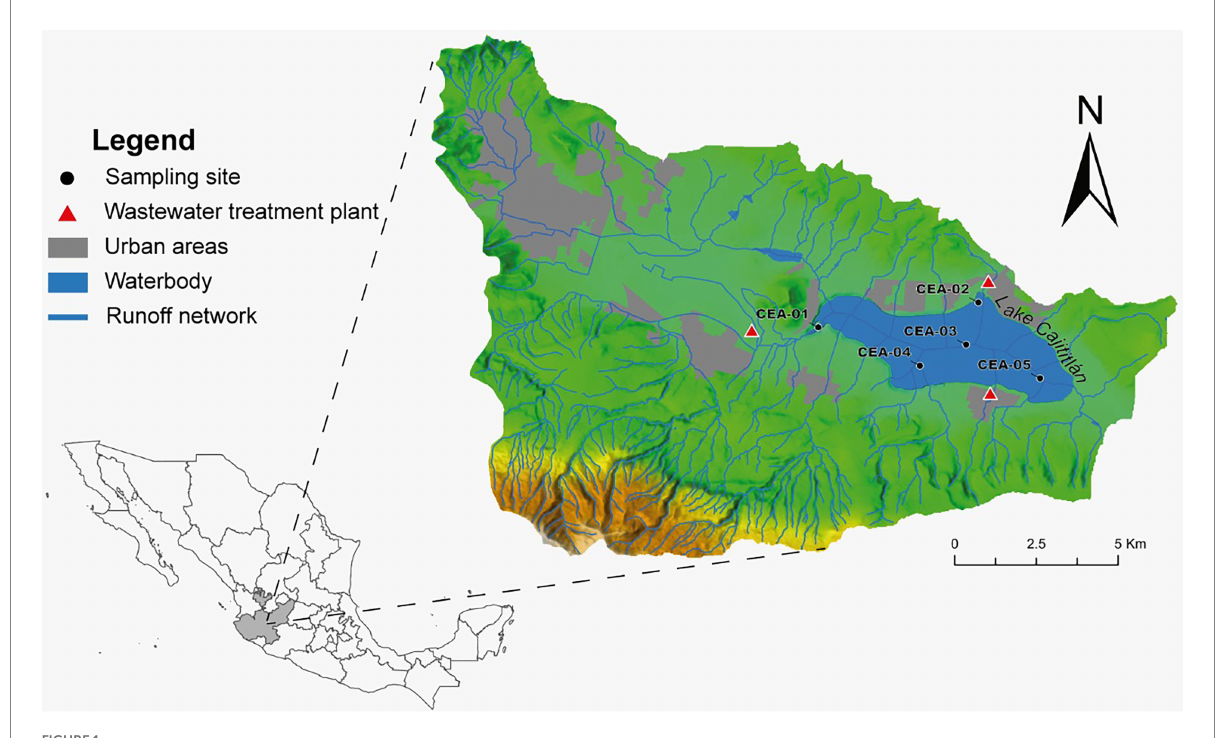
FIGURE 1 Locations of the sampling points in Lake